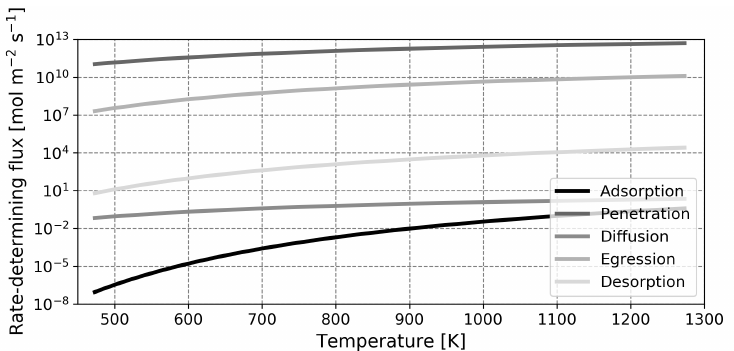
Figure 8. Representation of the hydrogen flux through an indium membrane for different rate- determining elementary reaction steps. A membrane with a thickness of 100µm was